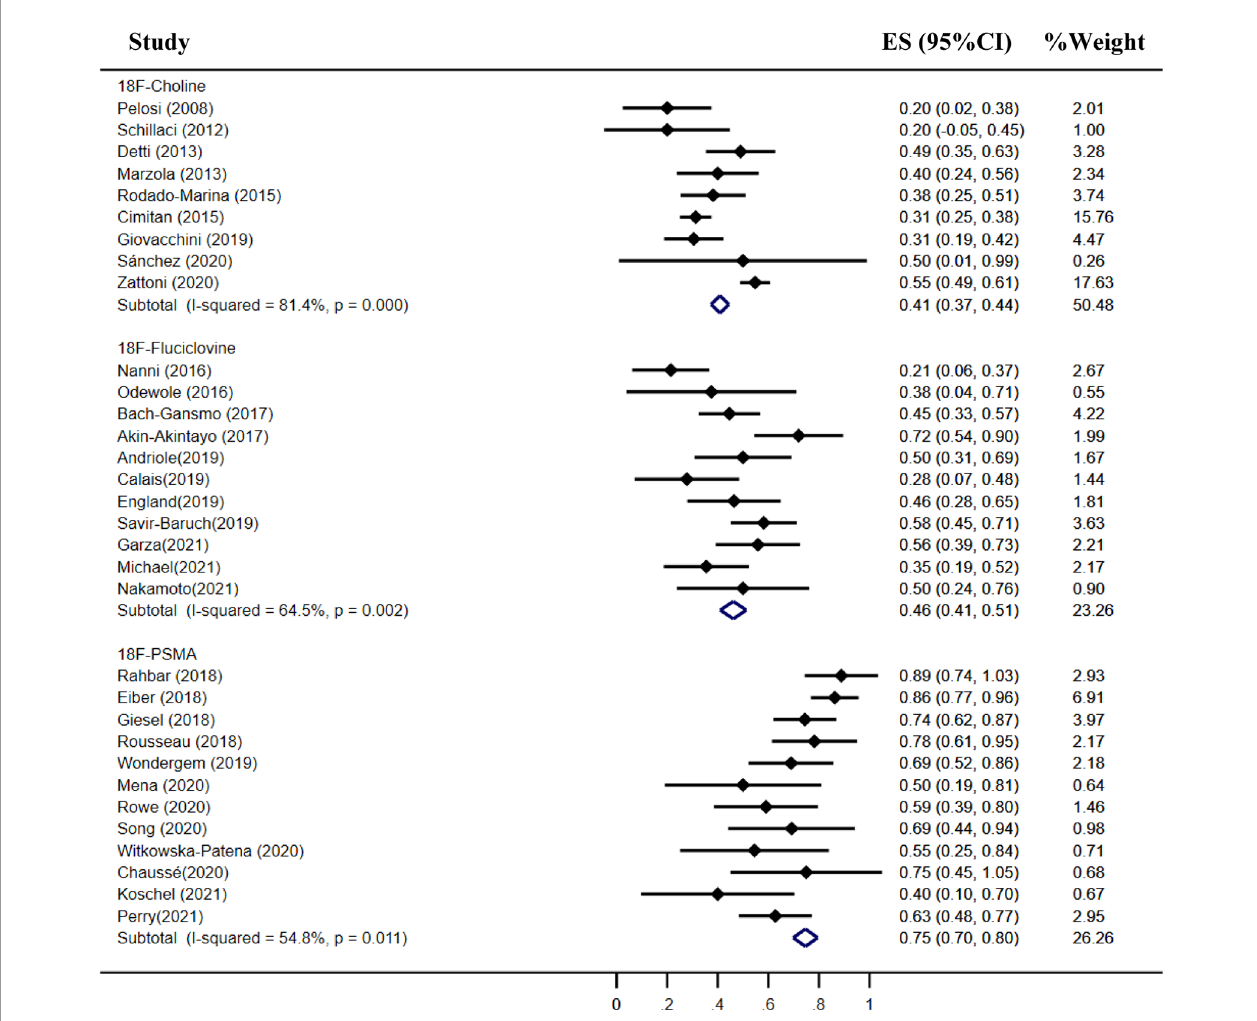
FIGURE 8 | Forest plot of the proportion of 18 F-labeled choline, fl uciclovine, and PSMA positivity of prostate cancer patients with BCR for PSA 0.5 – 0.99